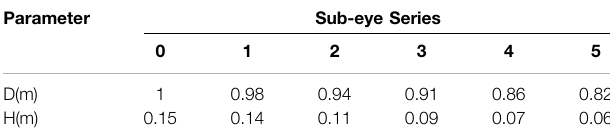
TABLE1| Tableofdimensionalparametersofsub-eyelensesofeachstage(mm).